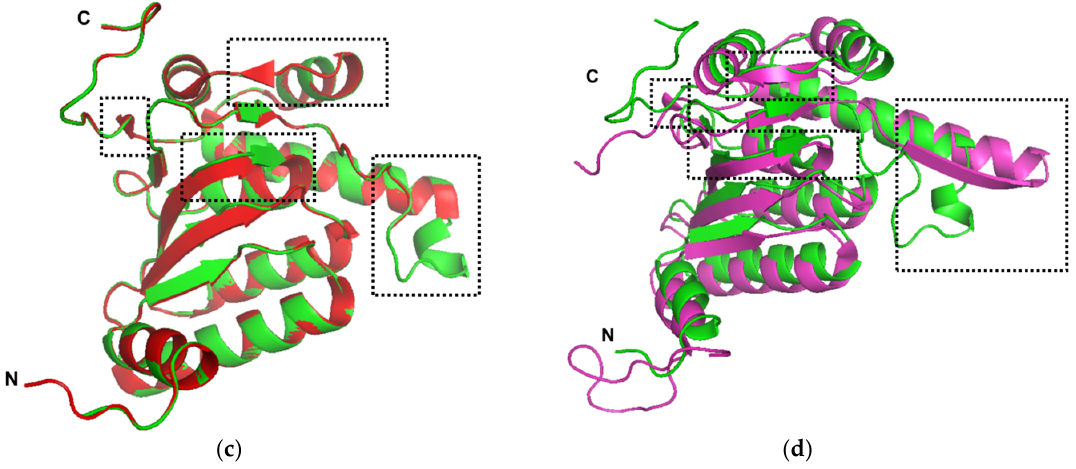
Figure 2. ( a ) The three-dimensional model of the ClpP from Plasmodium knowlesi (Pk-ClpP) in its oligomerization state. The monomeric form of Pk-ClpP is shown in green. ( b ) A close-up of the three-dimensional model of the monomeric form of ClpP from Plasmodium knowlesi . The N- and C- terminals of the protein were labeled as N- and C, respectively. The secondary structure arrangement was labeled with the number for clarity. The box is a close-up view of the triad catalytic site of Ser86-His112-Asp161. ( c ) Structural alignment between Pk-ClpP (green) and Pf-ClpP (red). The boxes in the dotted line indicate the structural differences between Pk-ClpP and Pf-ClpP. ( d ) Structural alignment between Pk-ClpP (green) and Ec-ClpP (purple). The boxes in the dotted line indicate the structural differences between Pk-ClpP and Ec-ClpP.